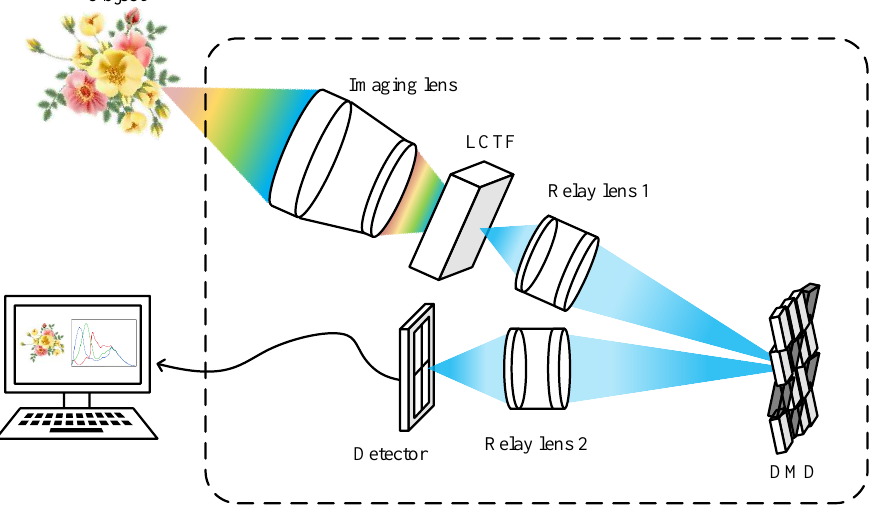
Figure 1. Schematic of coded aperture tunable filter (CATF) spectral imager. The reflected light source from the object is modulated by liquid crystal tunable filter (LCTF) and digital micromirror device (DMD). Each block on the DMD represents a micromirror unit. The micromirror unit in ON state (in white) reflects the light along the main optical axis to the detector, while the unit in OFF state (in black) reflects the light far away from the main optical